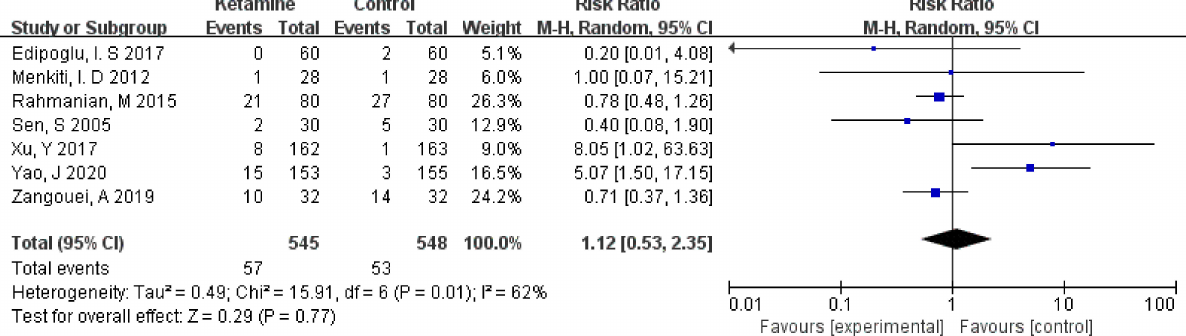
Figure 3. Forest plot of headaches